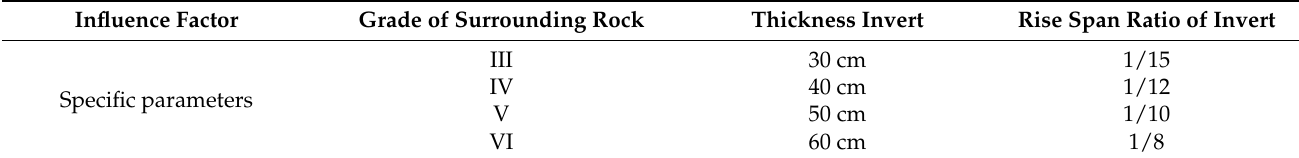
Table 6. Calculation cases with different design parameters of the tunnel base structure.